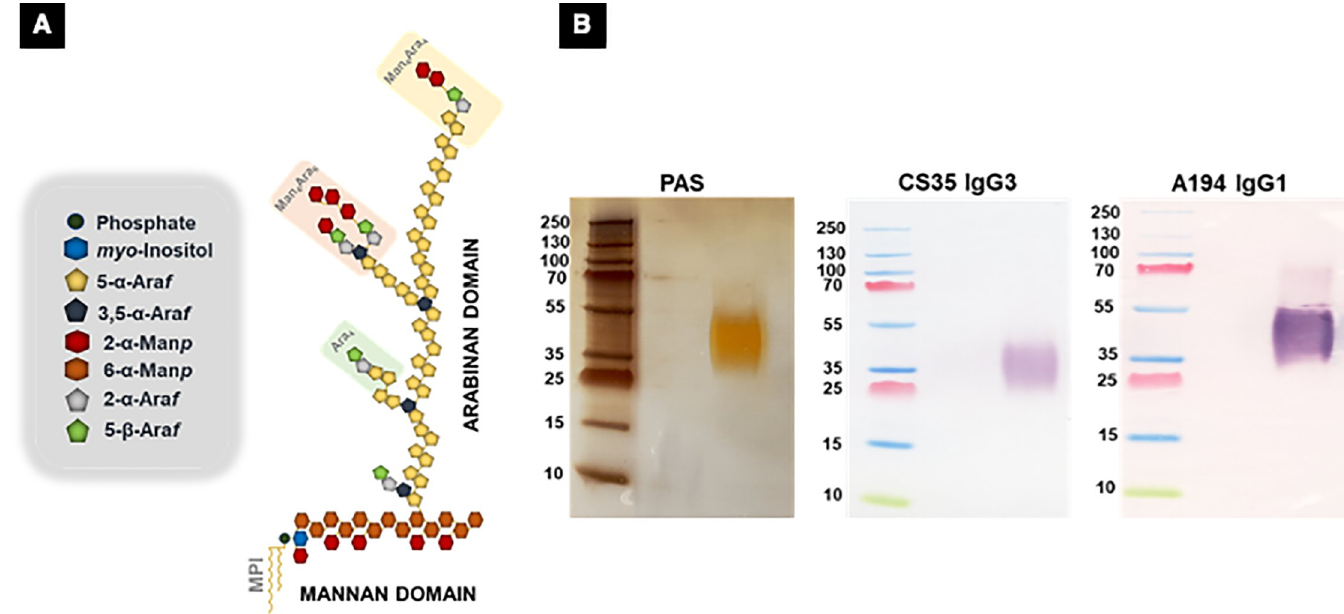
Fig 1. A. Structure of LAM. A major component of the cell envelope of Mtb is lipoarabinomannan (LAM). LAM is a complex of D-mannan and D-arabinan attached to a phosphatidyl- myo -inositol (PI) moiety that anchors in the mycobacterial cell wall [7]. The D-mannan consist of a highly branched structure with an α -(1 ! 6)-linked mannopyranose (Man p ) backbone substituted at C-2 by single Man p units. The arabinan consists of a linear α -(1 ! 5)-linked Ara f backbone punctuated by branching produced by 3,5- O- linked α -D-Ara f residues. The lateral side chains are organized either as a linear tetra-arabinofuranoside or as a biantennary hexa- arabinofuranosides [13, 38]. These chain terminating arabinan can be further capped with short mannose α -(1 ! 2)-linked oligosaccharides and are epitopes for binding to mAbs used in this study. B. Periodic Acid Silver Staining of Mtb CDC1551 LAM. LAM purified from in vitro grown cells showing a tight smear (MW ~ 15–17 kDa). Western blot profile of the CDC1551 LAM with the anti-LAM mouse monoclonal CS35 antibody and anti-LAM human monoclonal A194, the two antibodies used as a pair in our Capture ELISA.